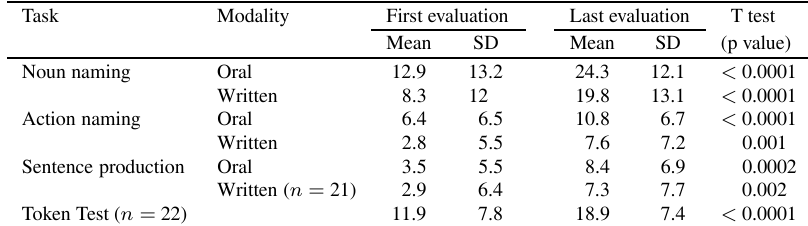
Table 5 Comparison of oral and written noun and action naming, sentence production, and Token